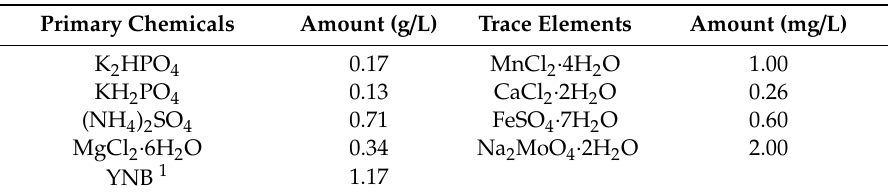
Table 2. Composition of the mineral medium, pH